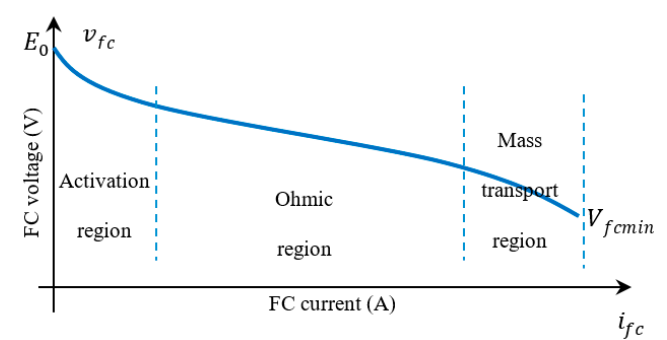
Figure 3. Nonlinear i-v characteristic of the fuel cell.